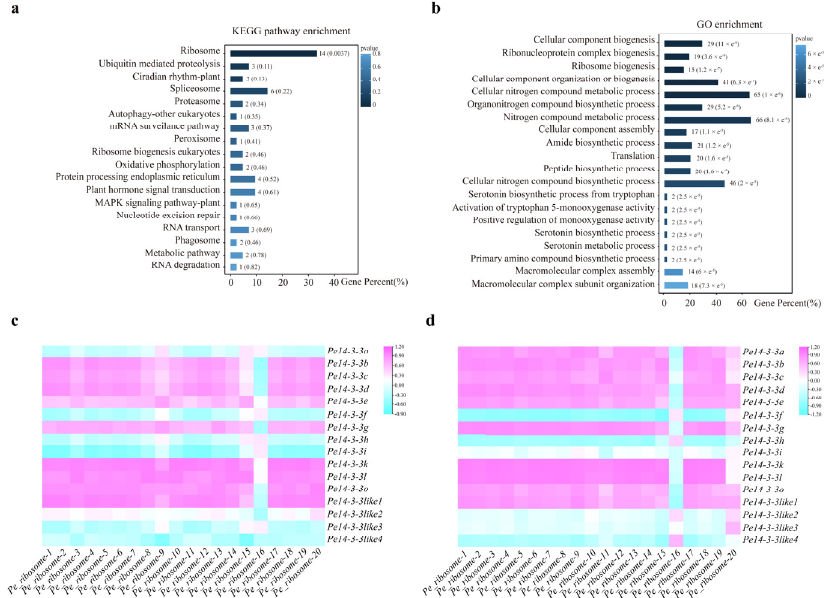
Figure 4. Function and correlation analysis of the genes co-expressed with Pe14-3-3 s involved in the ribosome pathway. ( a ) KEGG pathway enrichment analysis of the genes co-expressed with 16 Pe14-3-3 s. ( b ) GO enrichment analysis of the genes co-expressed with 16 Pe14-3-3 s. Low p -values are shown in dark blue and high p -values are depicted in light blue. ( c ) The correlation analysis between 16 Pe14-3-3 s with genes that participate in the ribosome pathway in the different height shoots of P . edulis . ( d ) The correlation analysis between 16 Pe14-3-3 s with genes participated in the ribosome pathway in the roots of P . edulis with different lengths. The gradual change color from blue to purple indicates negative to positive correlation.